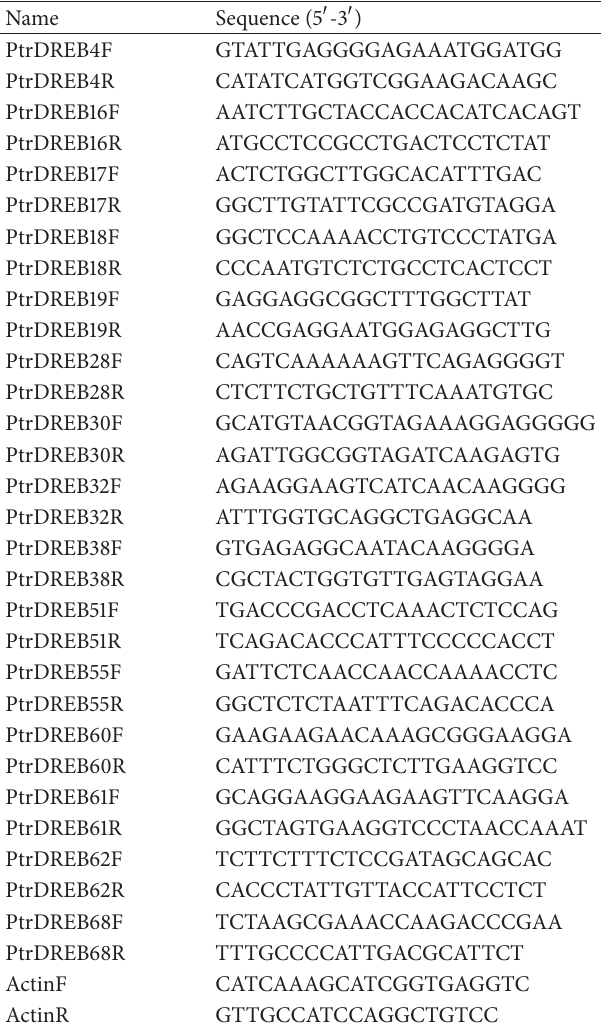
Table 1: The primers of DREB genes were generated in Primer 5 for qRT-PCR.